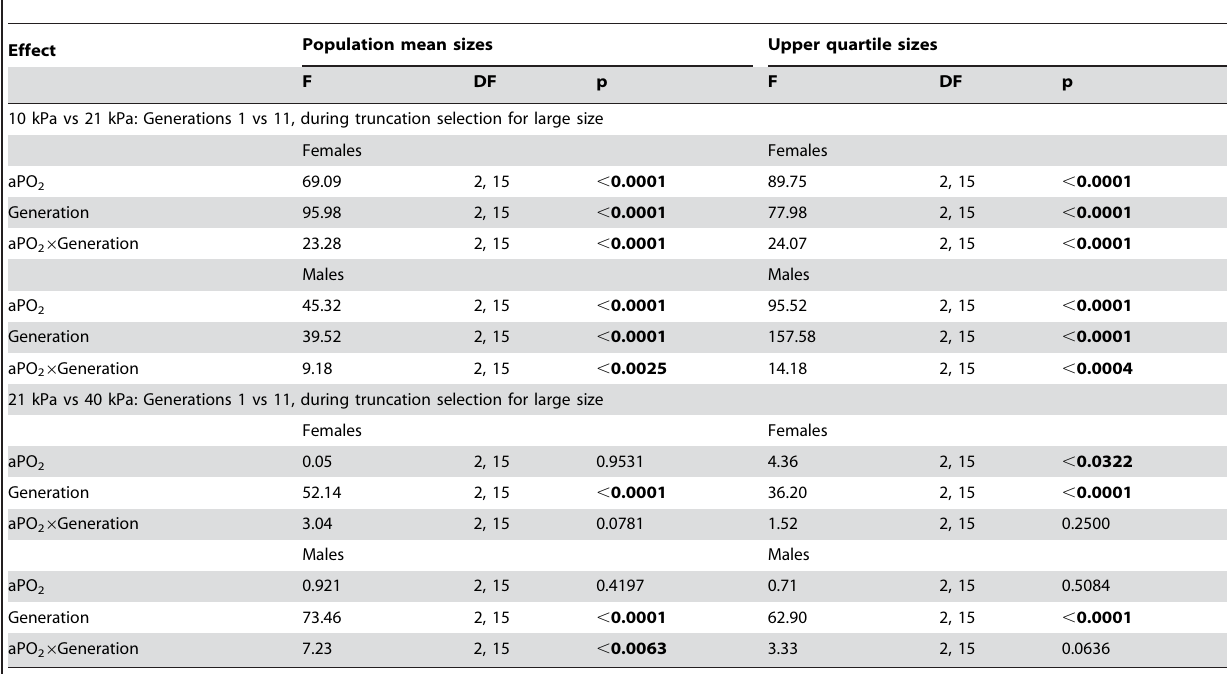
Table 1. Statistical analyses of fly size variation at the start vs the end of positive size selection.